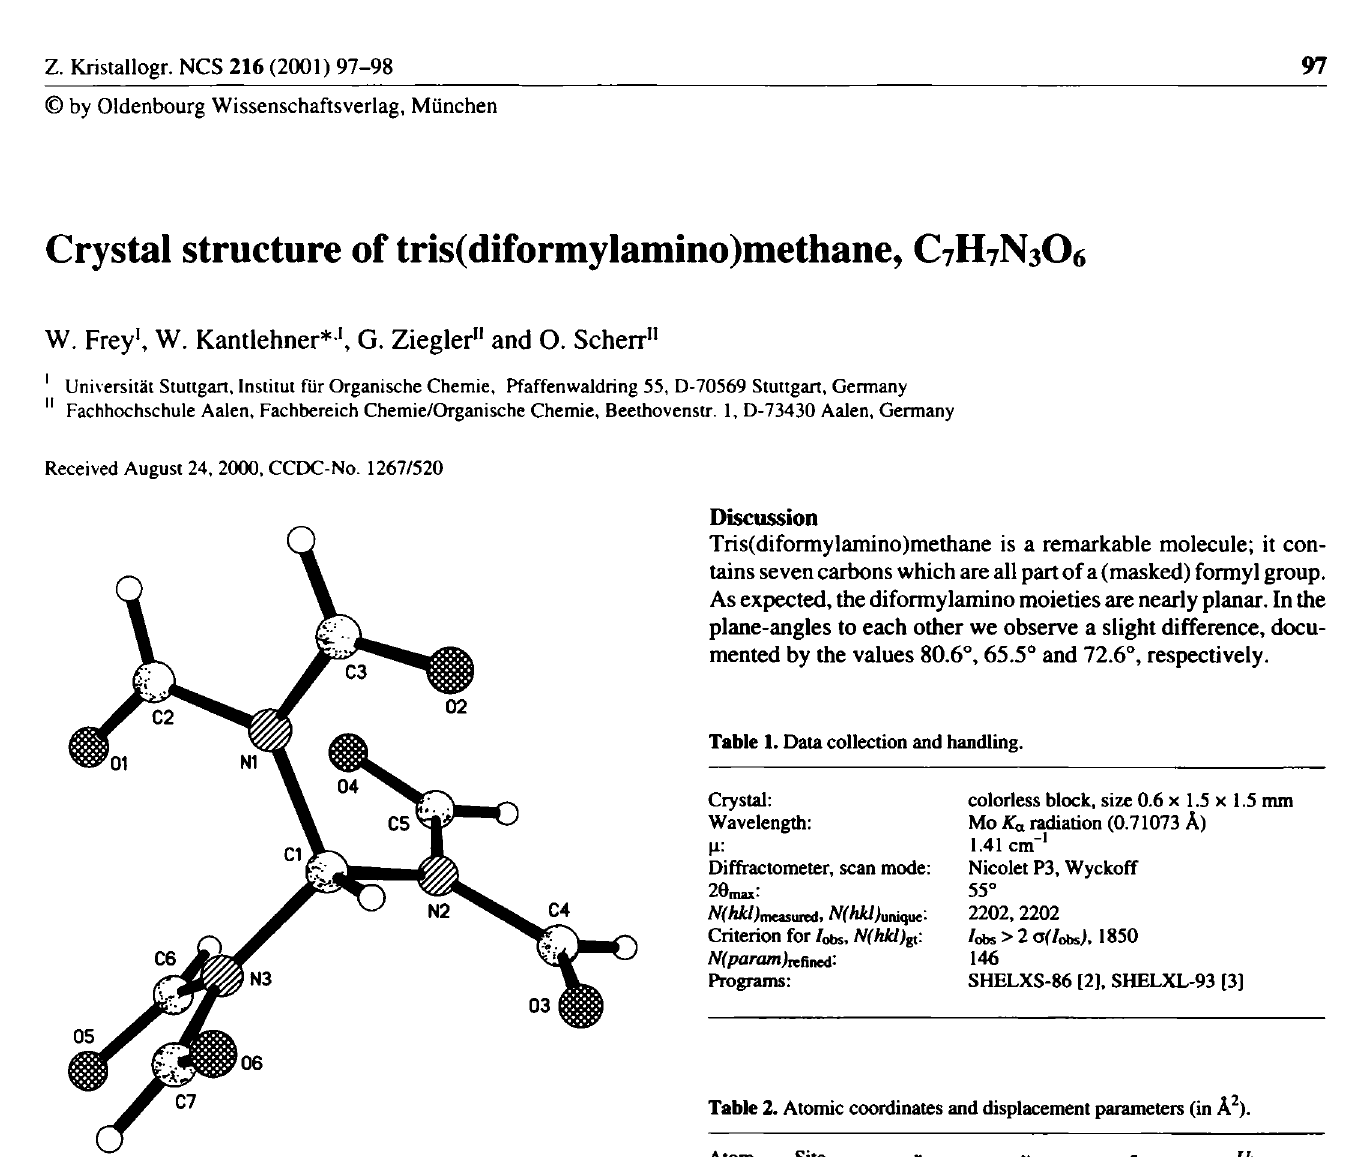
Table 2. Atomic coordinates and displacement parameters (in A 2